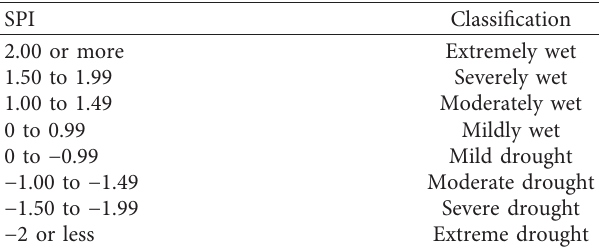
Table 1: SPI classification. SPI